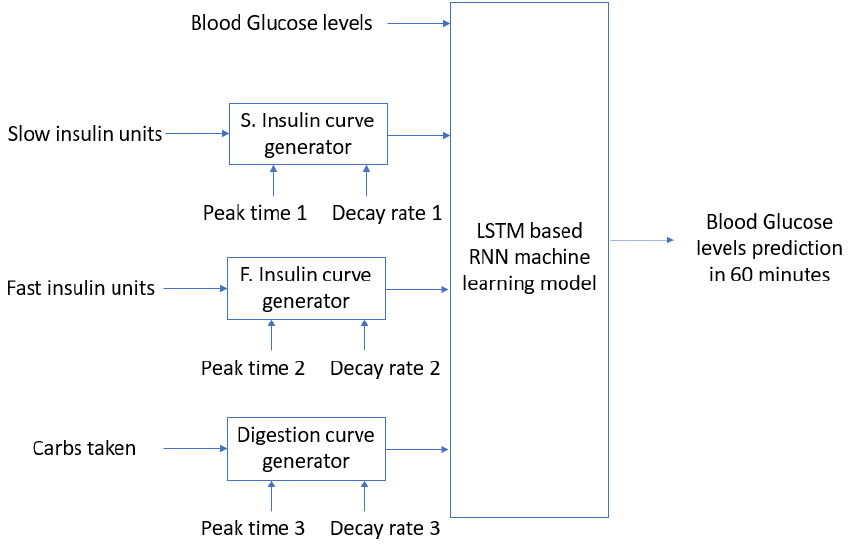
Figure 2. Machine learning model based of insulin absorption and meal digestion curves.